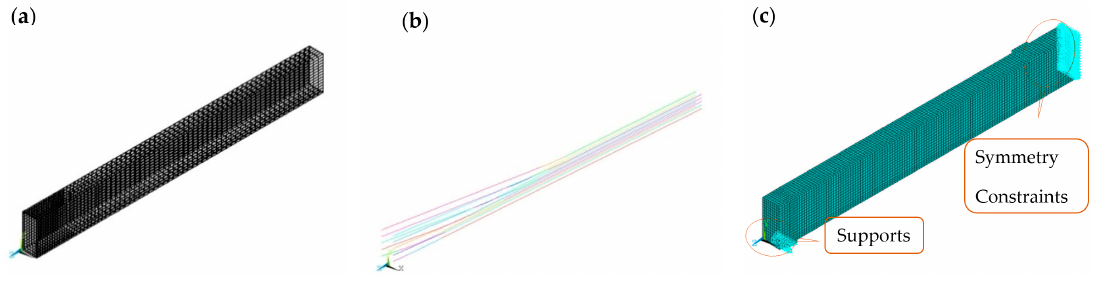
Figure 10. Finite element model based on the commercial finite element program ANSYS: ( a ) Reinforcement; ( b ) prestressed tendons; ( c ) 1/2 beam model.